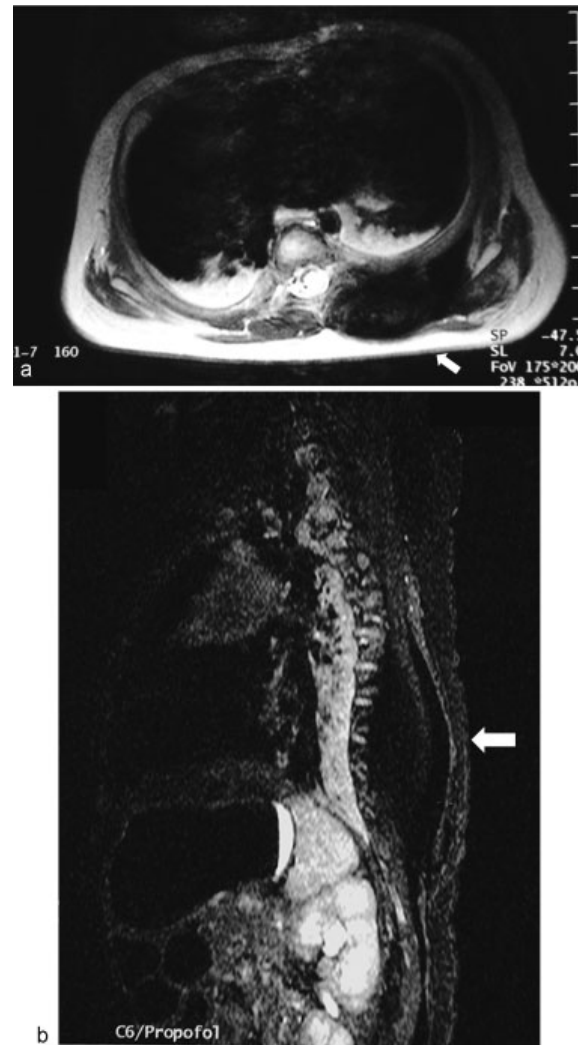
Fig. 5 MRI scan 16 weeks after birth Tumor size: 8 (cid:1) 5 cm. (a) Sagittal view. (b) Axial view. Arrows indicate tumor